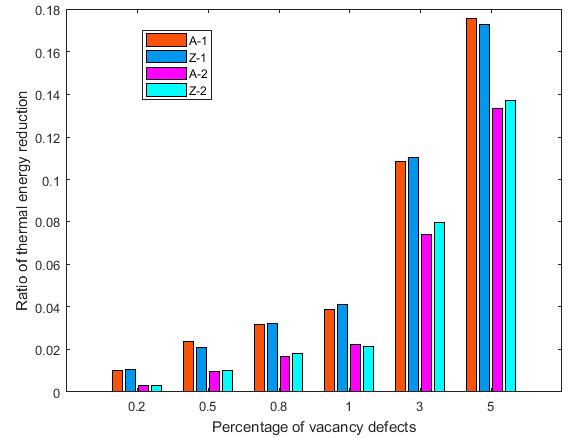
Figure 16. Ratio of thermal energy reduction (A-1 and A-2 are for minimum and maximum thermal energy in graphene with its heat source in armchair edges, respectively; Z-1 and Z-2 for minimum and maximum thermal energy in graphene with its heat source in zigzag edges, respectively).